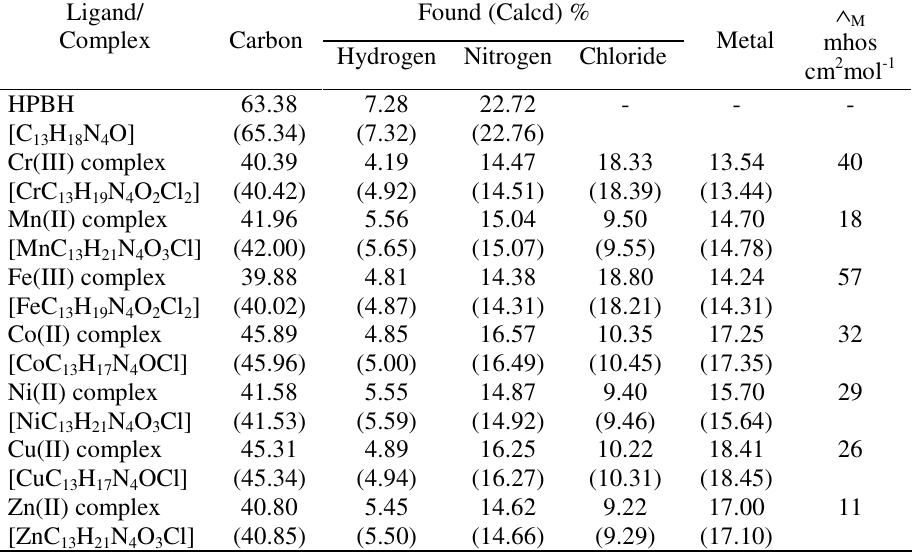
Table 1. Analytical and conductivity data of the ligand and metal complexes